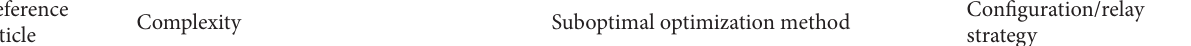
Table 1: Classification of articles based on network topology, with their corresponding complexity and suboptimal optimization method